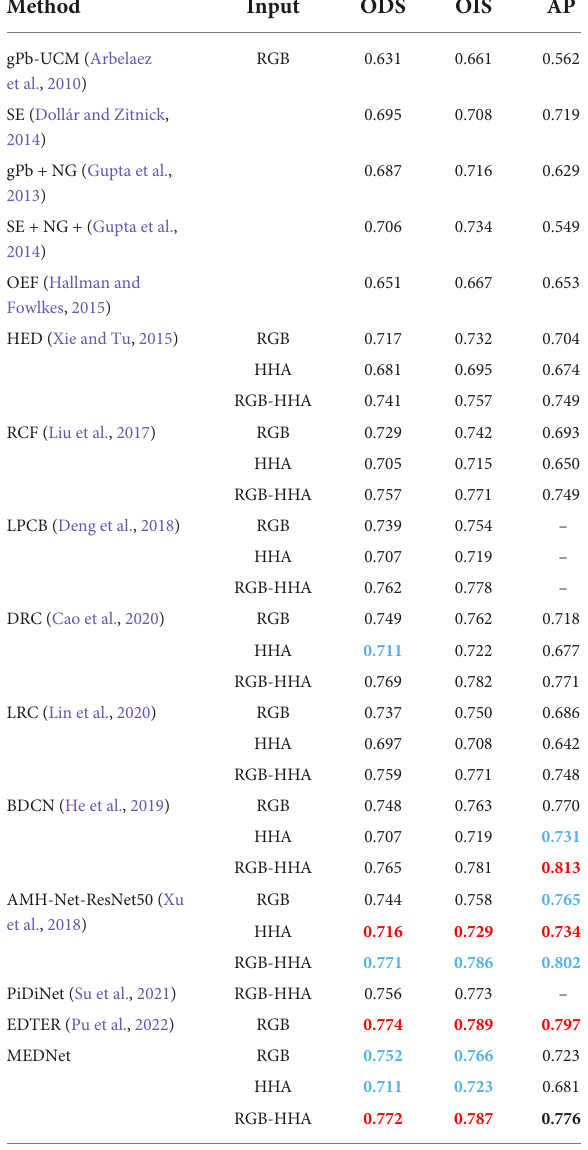
TABLE 4 Quantitative comparison results between the proposed method and other methods on nyud-v2 test set.